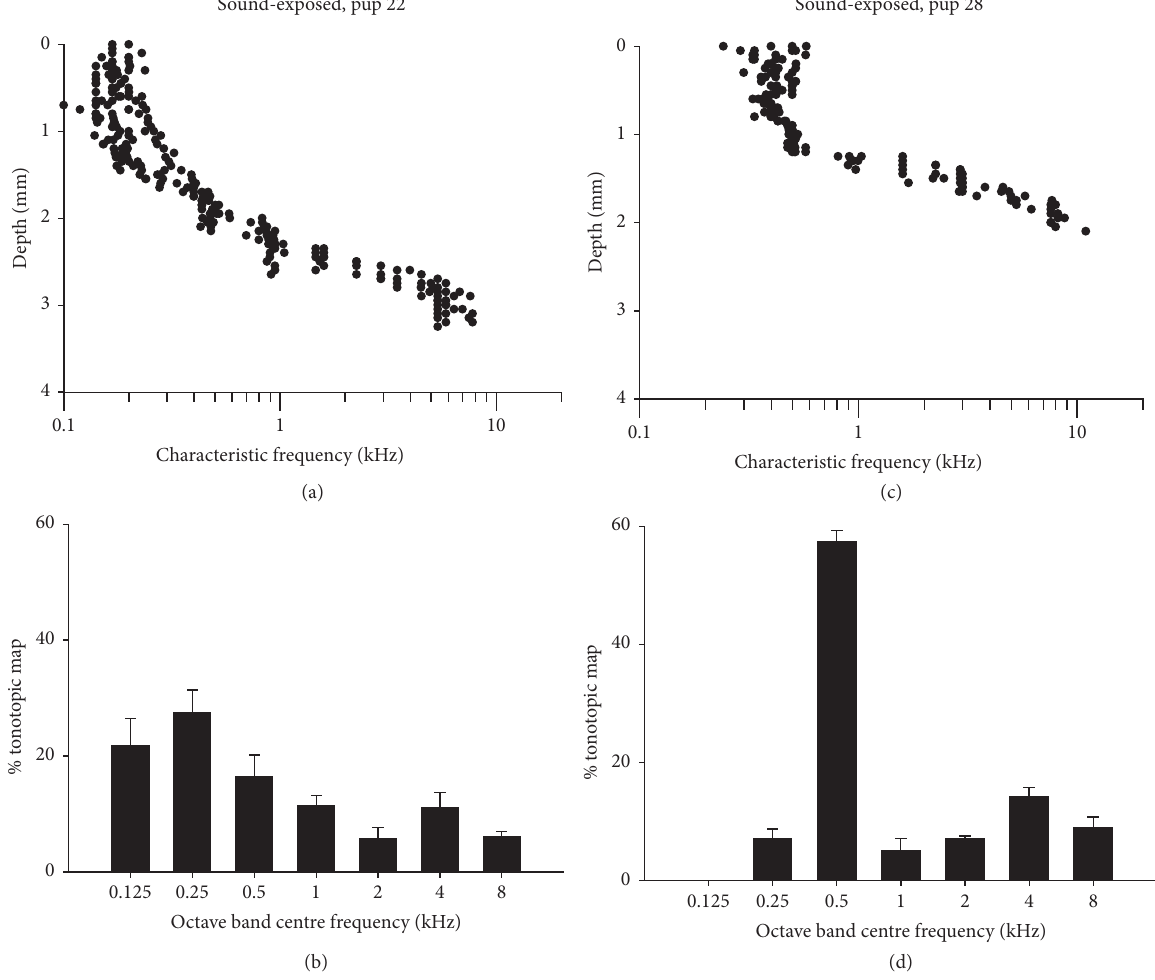
Figure 8: ((a) and (c)) Neuron CF versus dorsoventral electrode depth in IC (central nucleus) for two neonatally sound-exposed subjects. In (b) and (d) the proportion of neuron CFs within octave bands (center frequencies 0.125–8 kHz) are